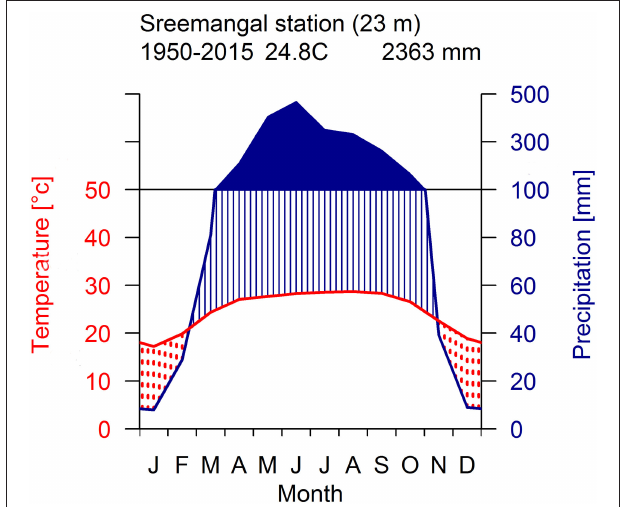
FIGURE 1 | Walter-Leith monthly climate diagram for the study area derived from data collected at meteorological station (Sreemangal, 23km) for the period 1950–2015. FIGURE 2 | Trends in local climate variables for the period over